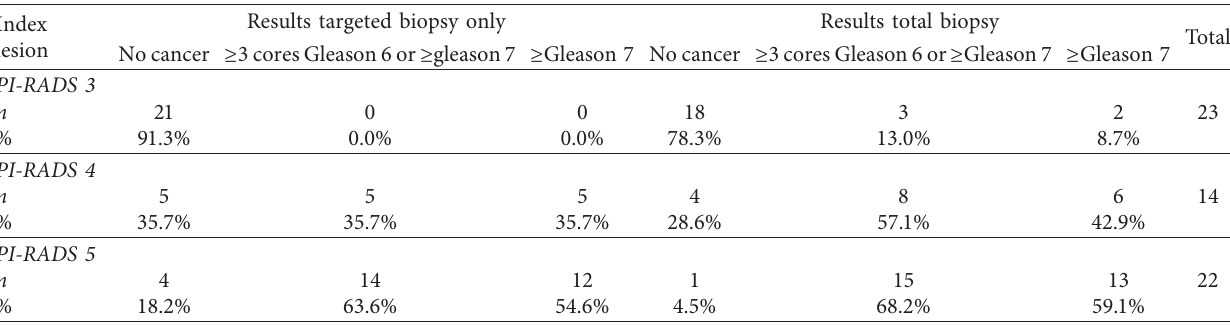
Table 4: Biopsy yield based on PI-RADS stratitication.